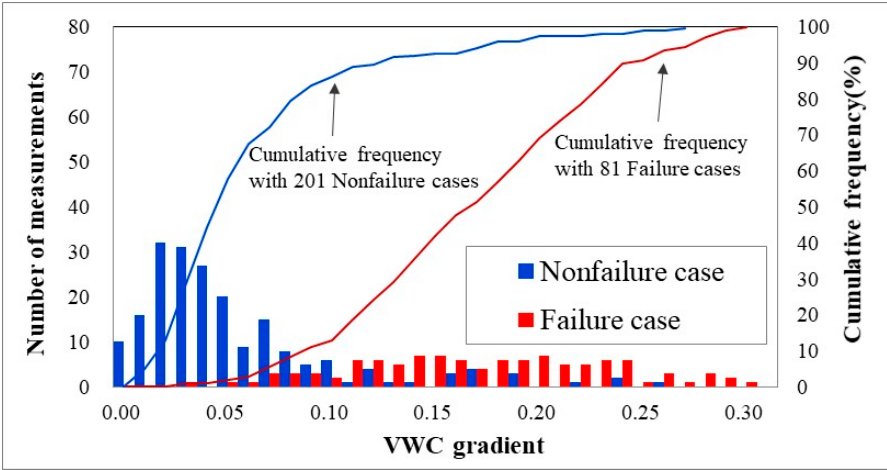
Figure 9. Comparison of frequency between nonfailure cases and failure cases.